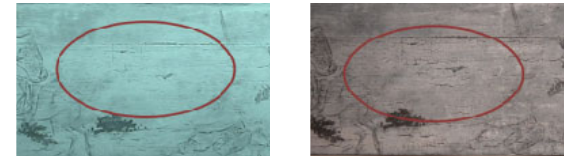
Figure 2. Outdoor wet air flowing into Taiwanese Temple